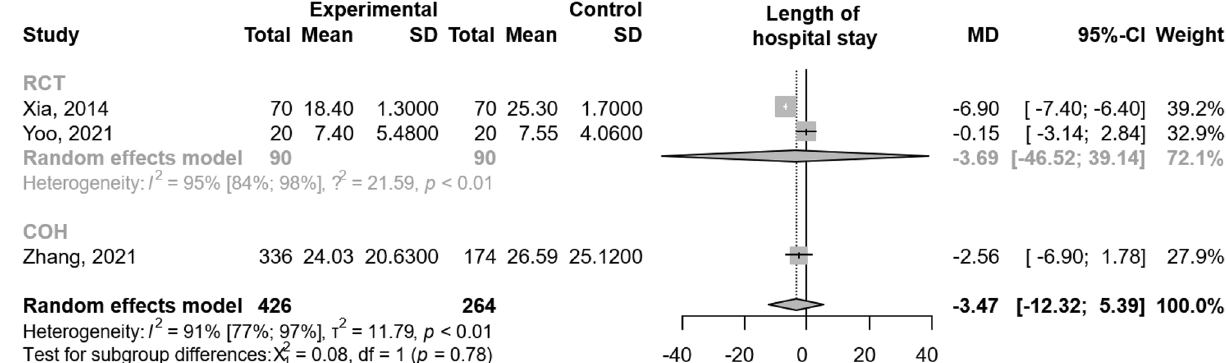
Figure 3. The addition of proton pump inhibitor treatment to standard of care in acute pancreatitis was not associated with a significant change in length of hospital stay by comparison with standard of care alone. MD mean difference, CI confidence interval, RCT randomized controlled trial, COH cohort study.